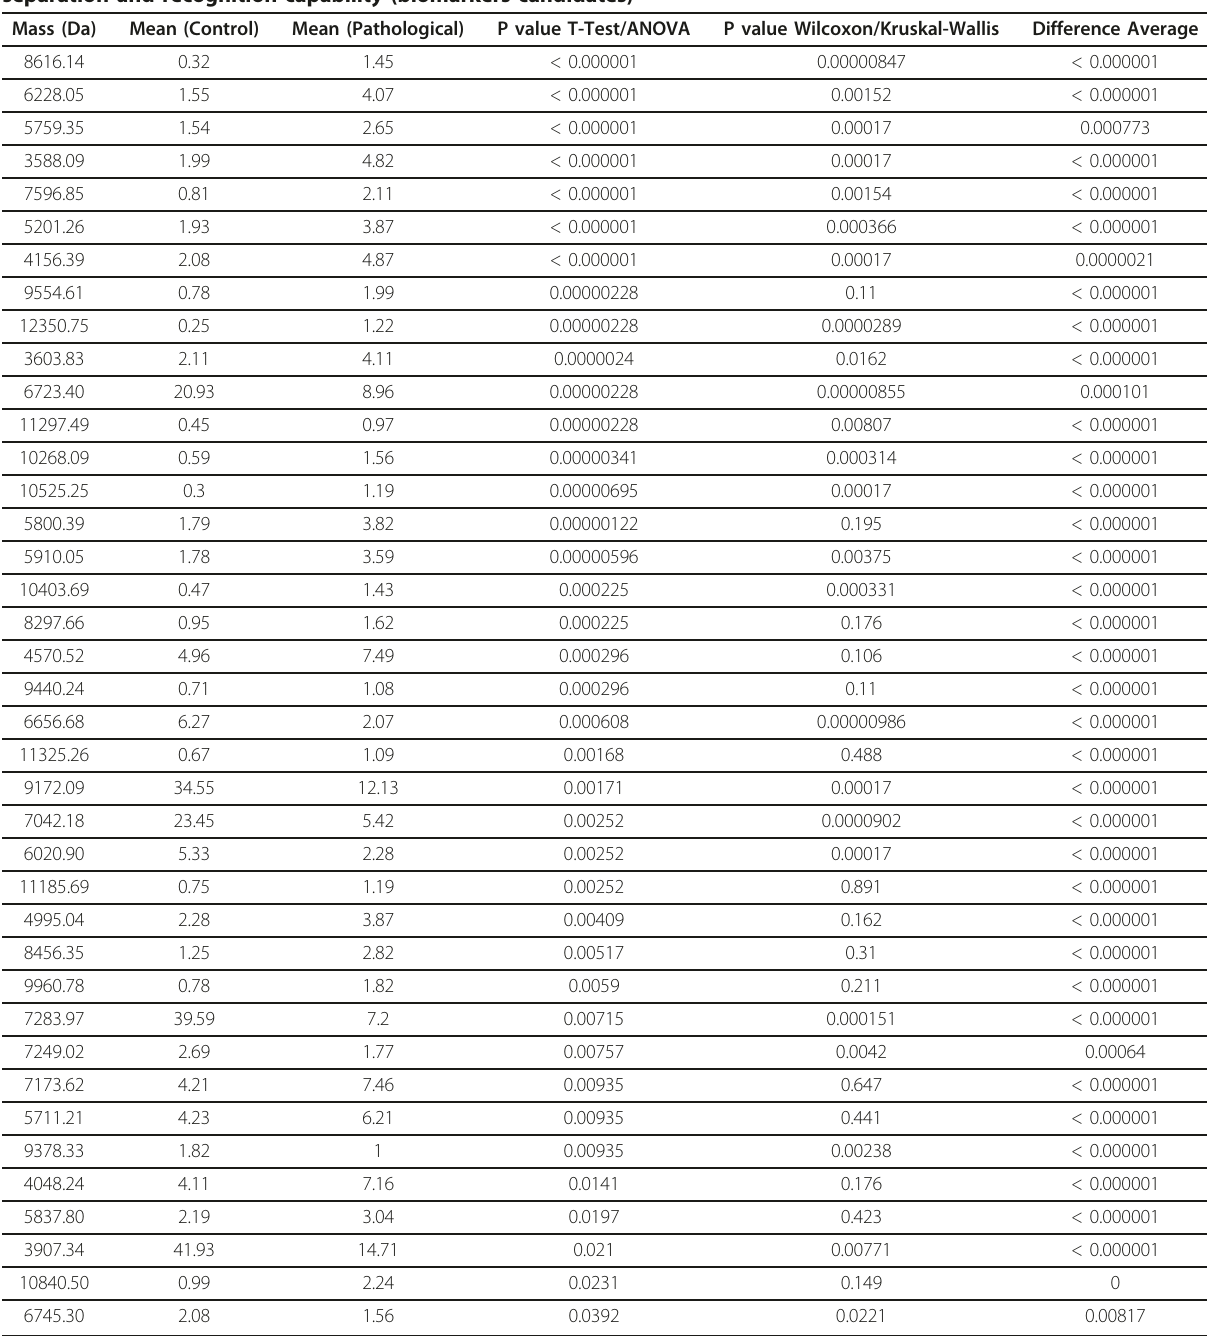
Table 1 Peak statistics - comparison of statistically important (p value of T-test/ANOVA < 0.05) peaks for data separation and recognition capability (biomarkers